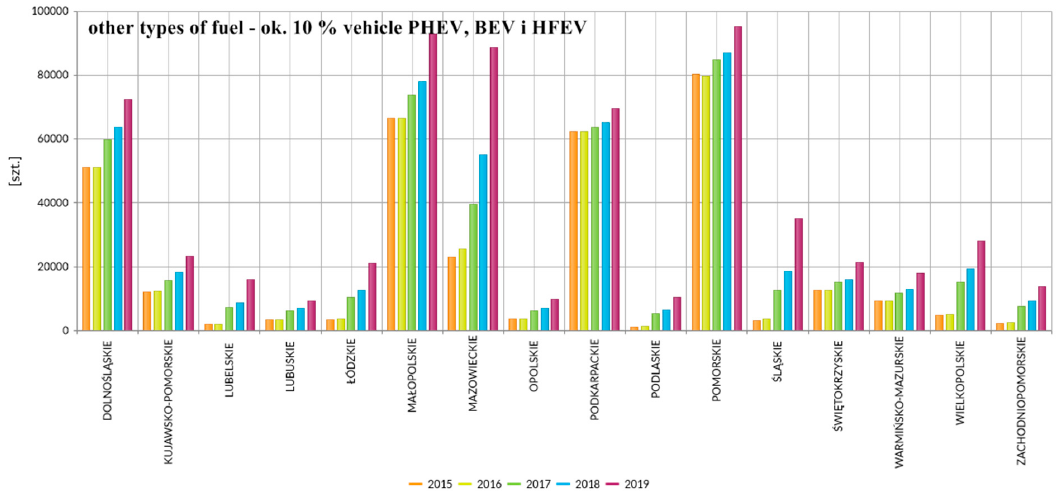
Figure 5. Number of vehicles powered by other energy source, e.g., PHEV, BEV and HFEV vehicles (they represent about 10% of the population).